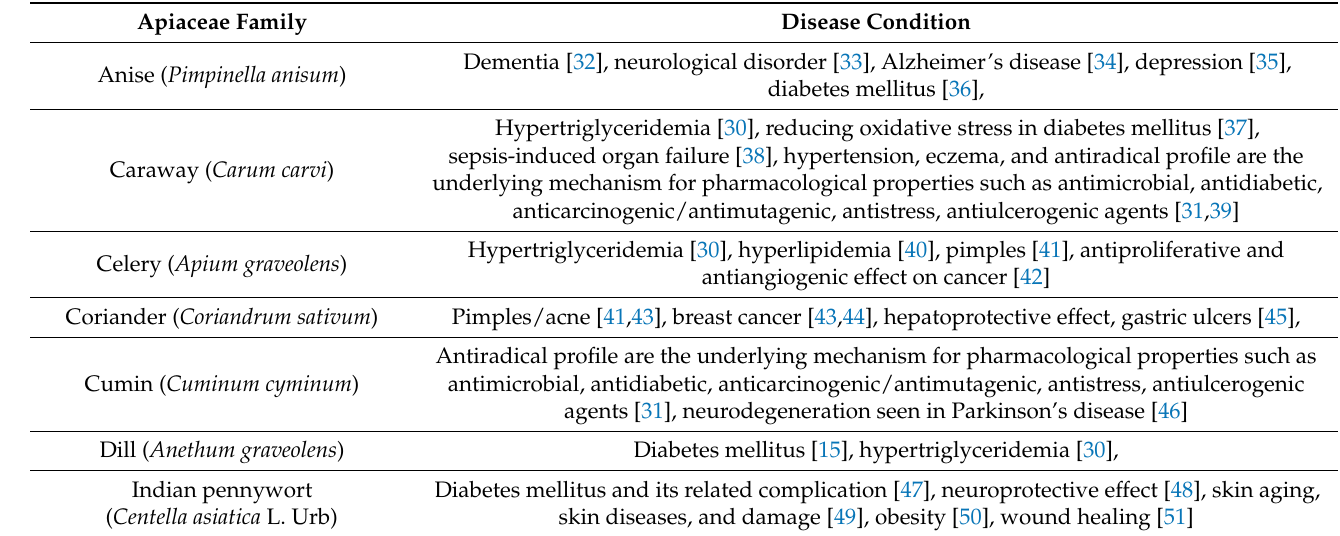
Table 1. Therapeutic effects of antioxidants from Apiaceae